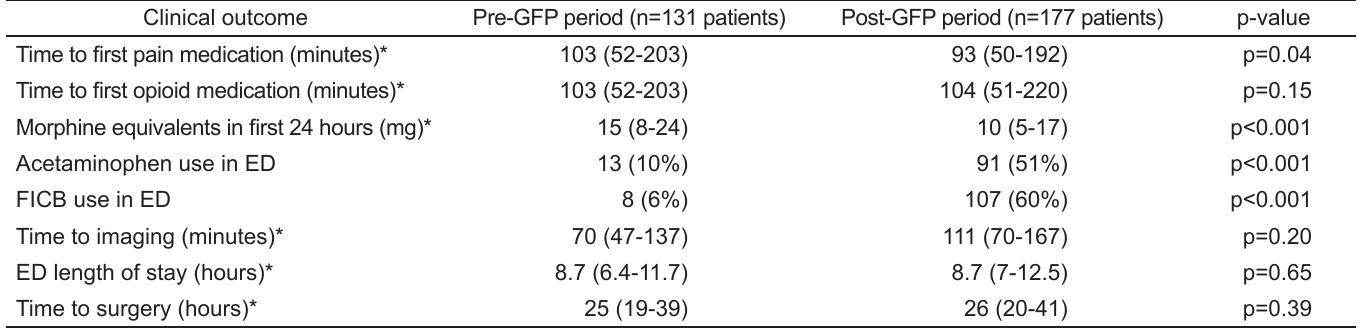
Table 2. ED pain management and time intervals before and after implementation of a geriatric fracture